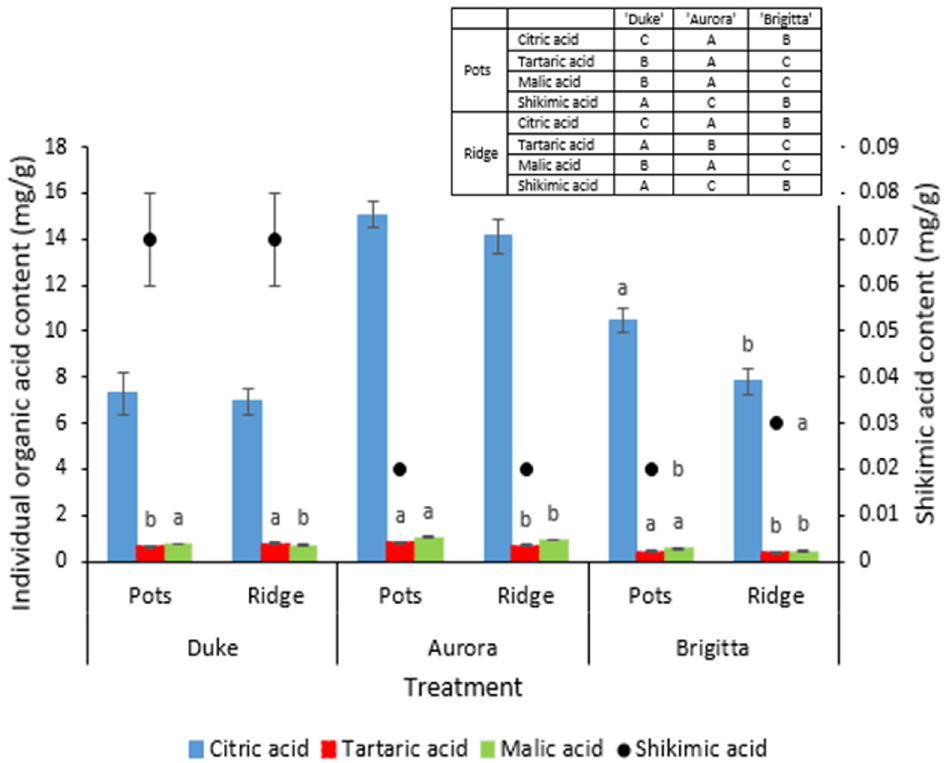
Figure 6. Citric, tartaric, malic, and shikimic acids contents for the blueberry ‘Duke’, ‘Aurora’, and ‘Brigitta’ fruit harvested from plants grown in pots and along the ridge. Different lowercase letters indicate statistically significant differences for each organic acid between planting methods within cultivars ( t -tests, α < 0.05), and different uppercase letters (inset) for each organic acid between cultivars within planting method (LSD tests, α < 0.05).